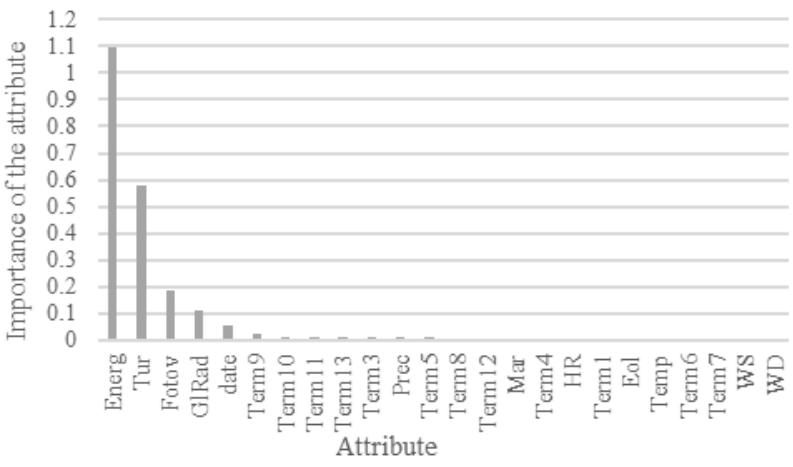
Figure 5. Importance of InfoGain attribute vs. attributes.